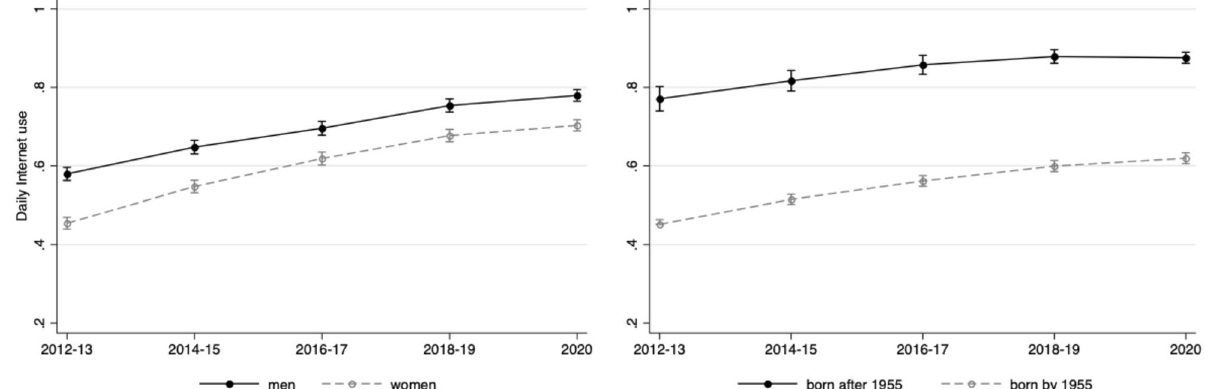
Figure 2. Weighted prevalence of daily Internet use over time, by gender and cohort. Estimates are from the English Longitudinal Study of Ageing, Waves 6 to 9 (2012–2019) and the COVID-19 Substudy Wave 1 (June/ July 2020), weighted using cross-sectional weights at each data collection wave.